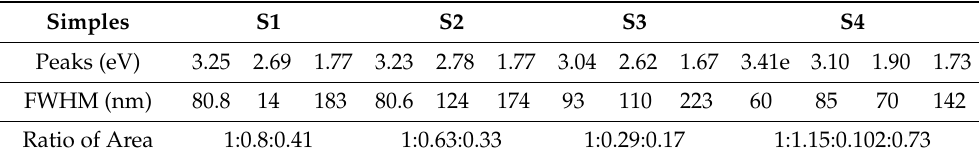
Figure 4. ( a ) Room Temperature photoluminescence excitation (PLE) and photoluminescence (PL) spectra of samples S1, S2, S3, and S4. ( b ) Deconvoluted PL spectra of samples S1, S2, S3, and S4. Table 3. PL analysis